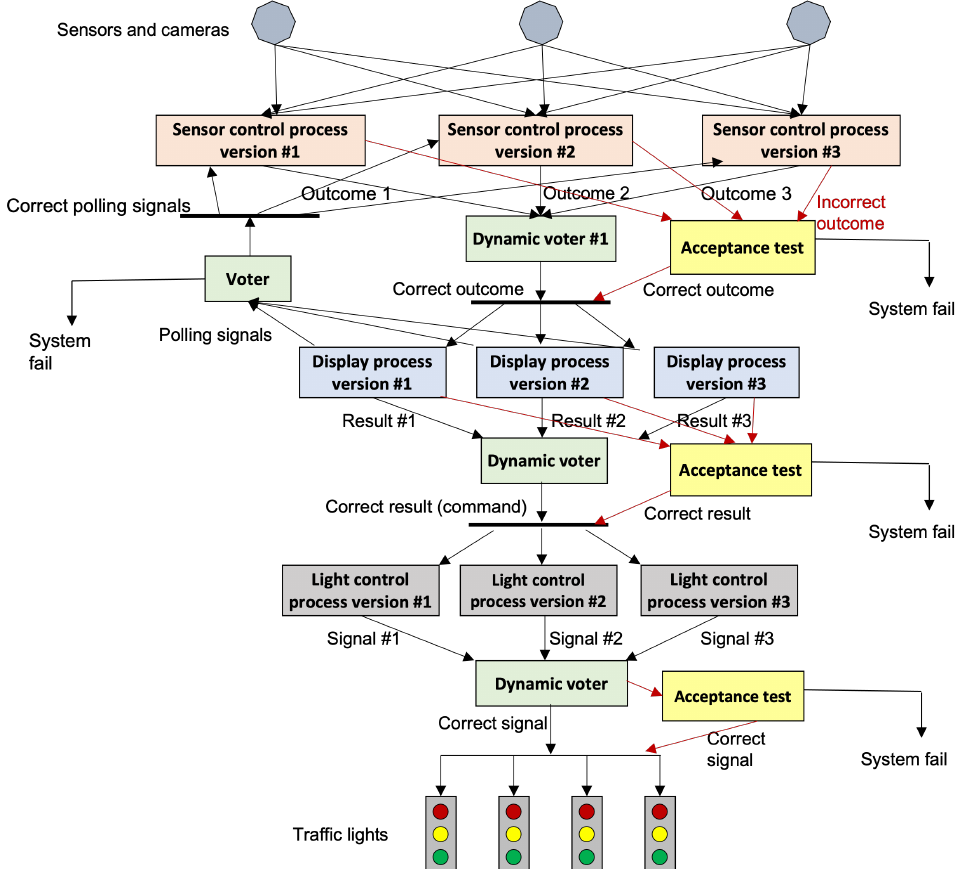
Figure 4. Resilient multiprocessor traffic control system based on voter and acceptance